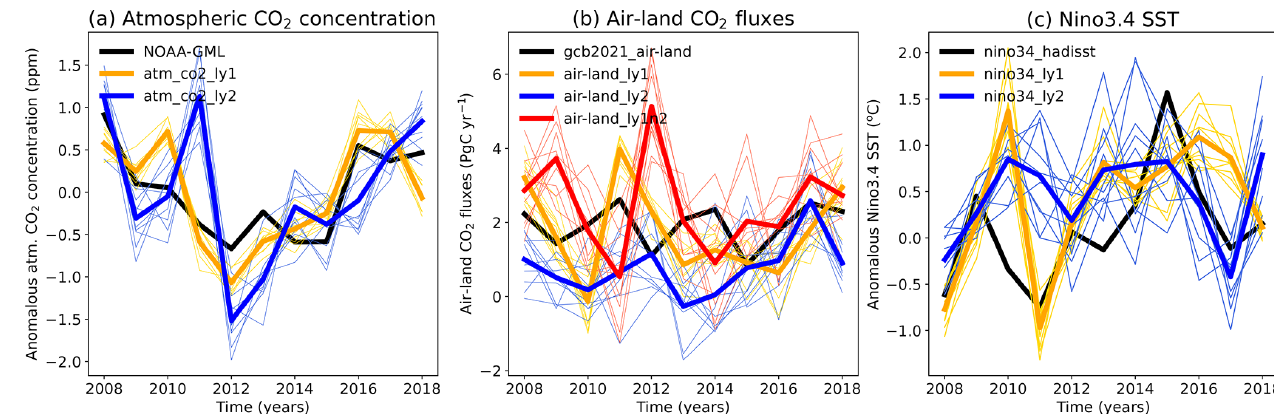
Figure 8. (a) Time series of atmospheric CO 2 concentration anomalies from initialized simulations at a lead time of 1 year and 2 years compared to the NOAA_GML observations (Dlugokencky and Tans, 2020) over the last 10 years. Anomalies are calculated by detrending the time series and with the climatological mean removed. (b) Time series of CO 2 fluxes from initialized simulations at a lead time of 1 year and 2 years together with estimates from the GCB2019. The red curves present the sum of predictions at a lead time of 2 years and the previous year of prediction at a lead time of 1 year (air–land_ly1n2). (c) Time series of nino3.4 SST from model simulations and HadISST (Rayner et al., 2002). The time series are original model outputs and concatenated according to the lead time of